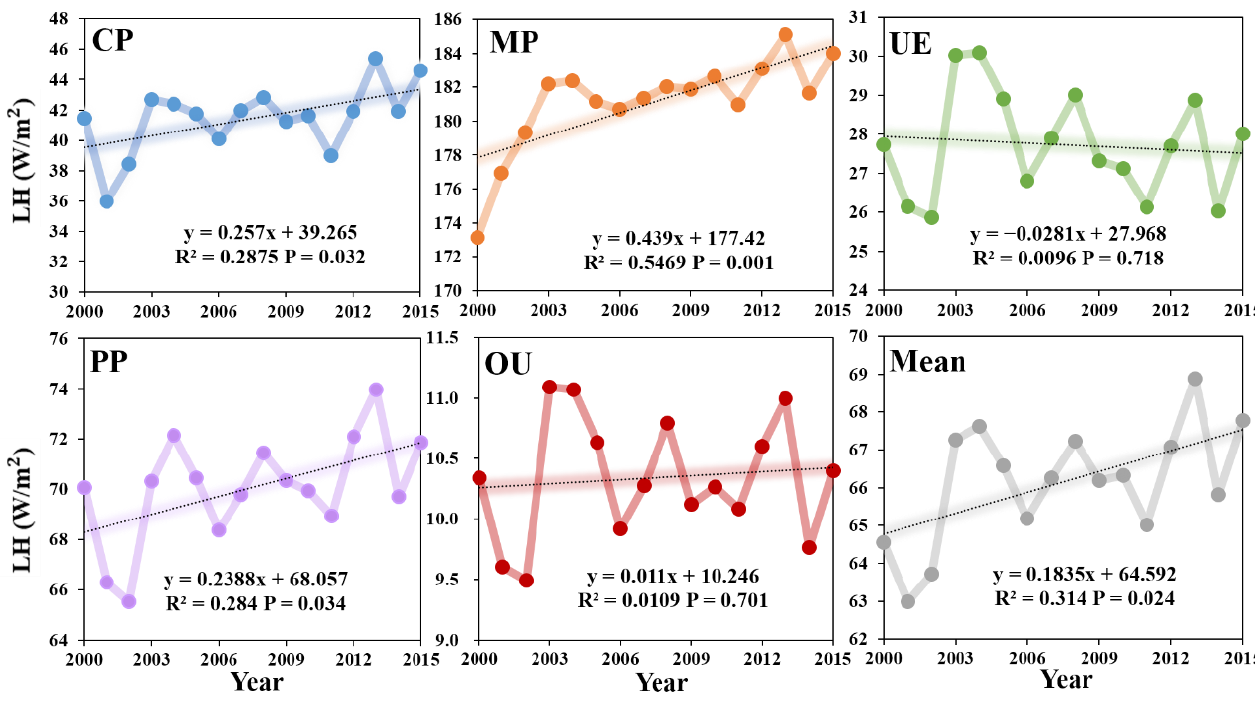
Figure 9. ( a ) Spatial variation of latent heat flux (LH) and ( b ) statistical values for the five land use types in the Huang-Huai-Hai River Basin from 2000 to 2015.